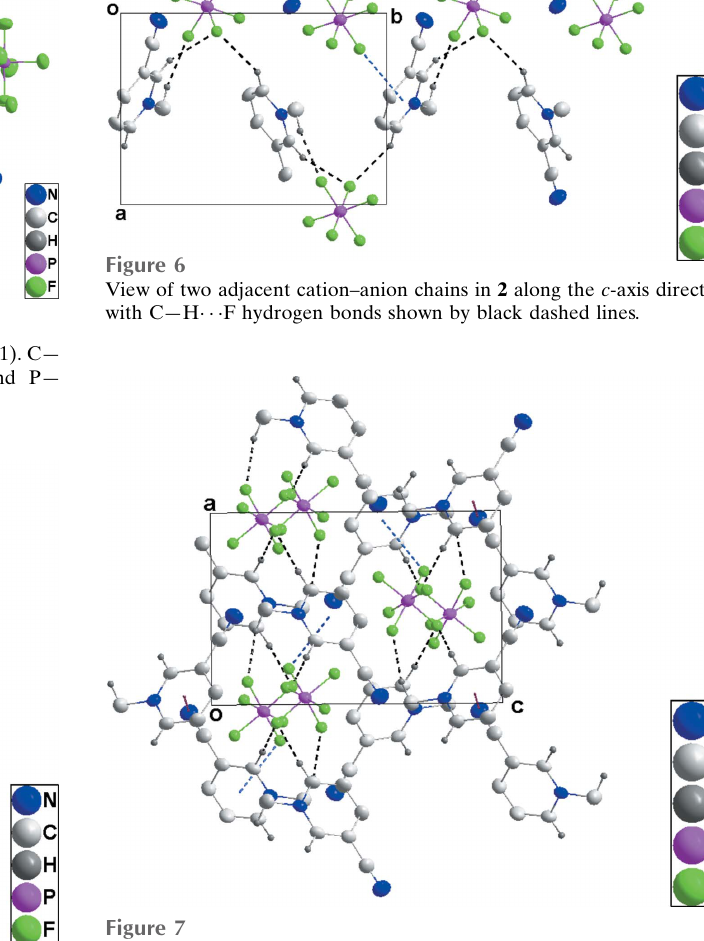
Figure 5 Packing of 1 viewed along the a -axis direction with C—H (cid:2)(cid:2)(cid:2) F hydrogen bonds shown as dashed lines.